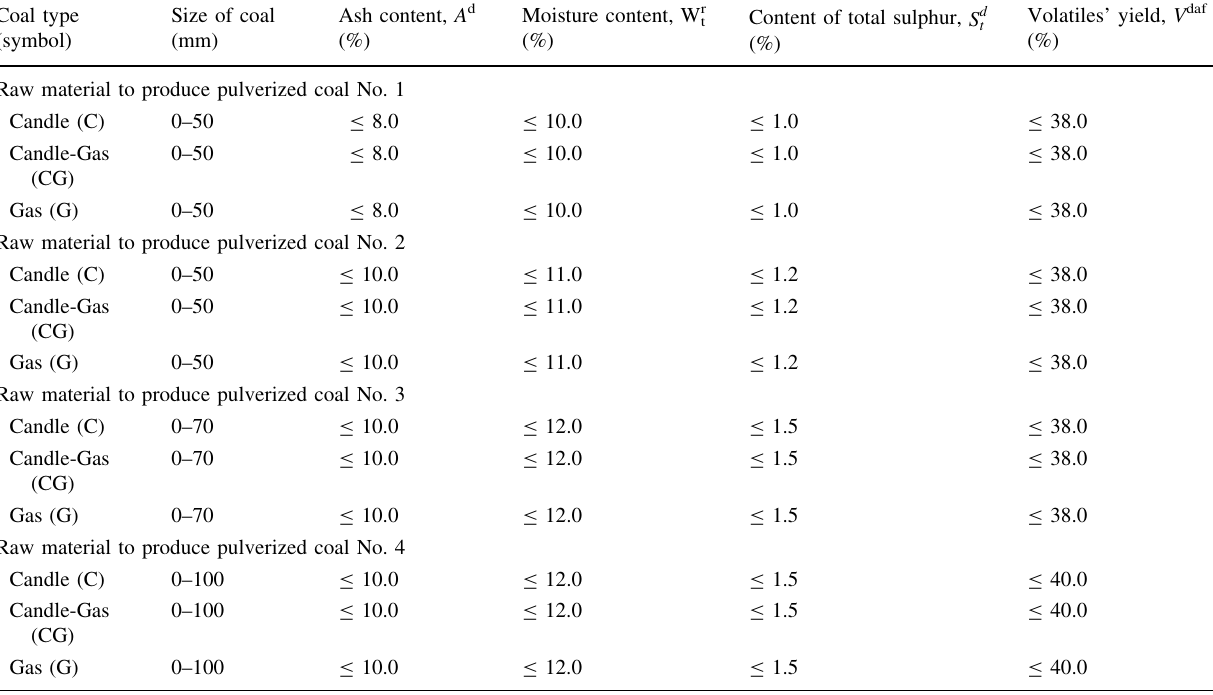
Table 5 Coal quality requirements for effective use in PCI technology Coal type